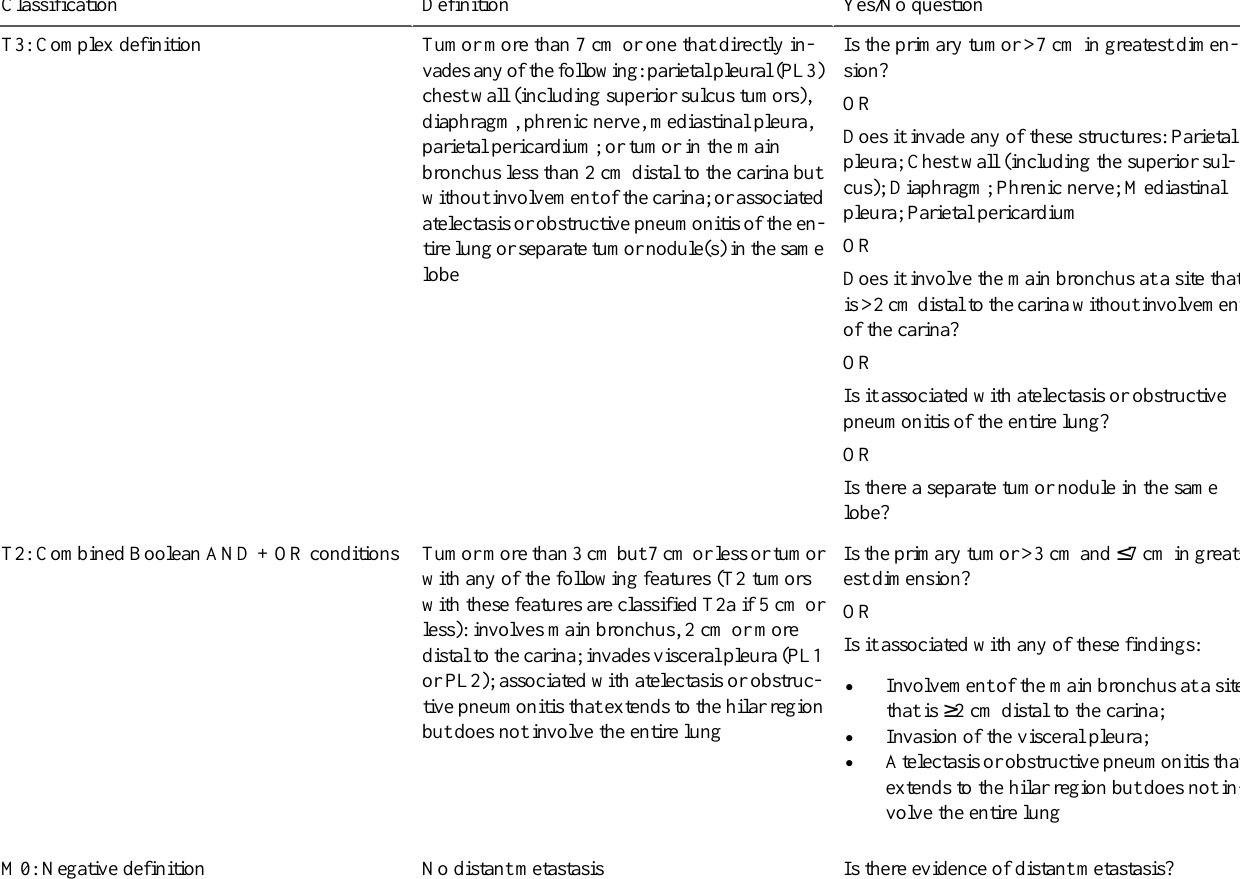
Table 3. Reconfiguration of classification criteria for cancer of the